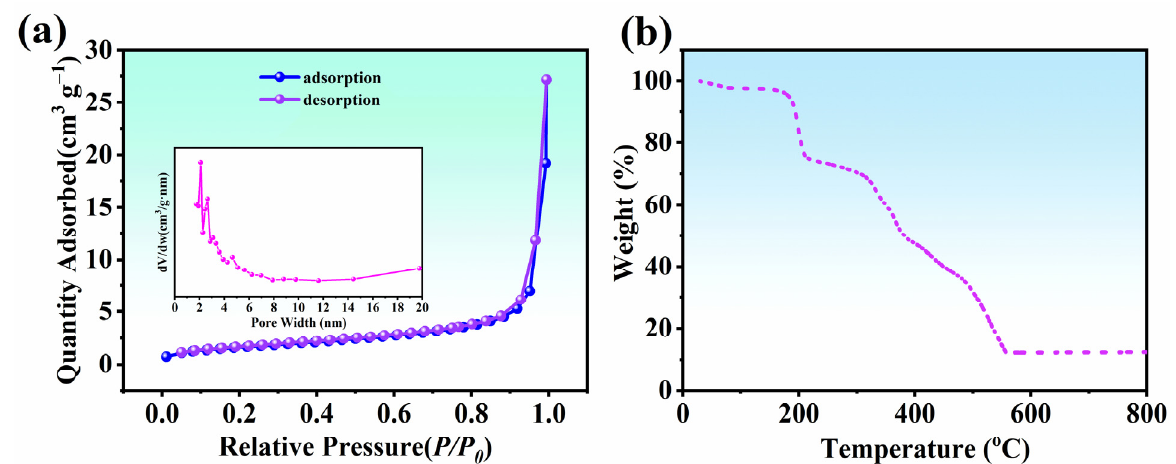
Figure 5. ( a ) N 2 adsorption–desorption isotherms and ( b ) TGA curve of Ce-H3TATAB-MOFs.